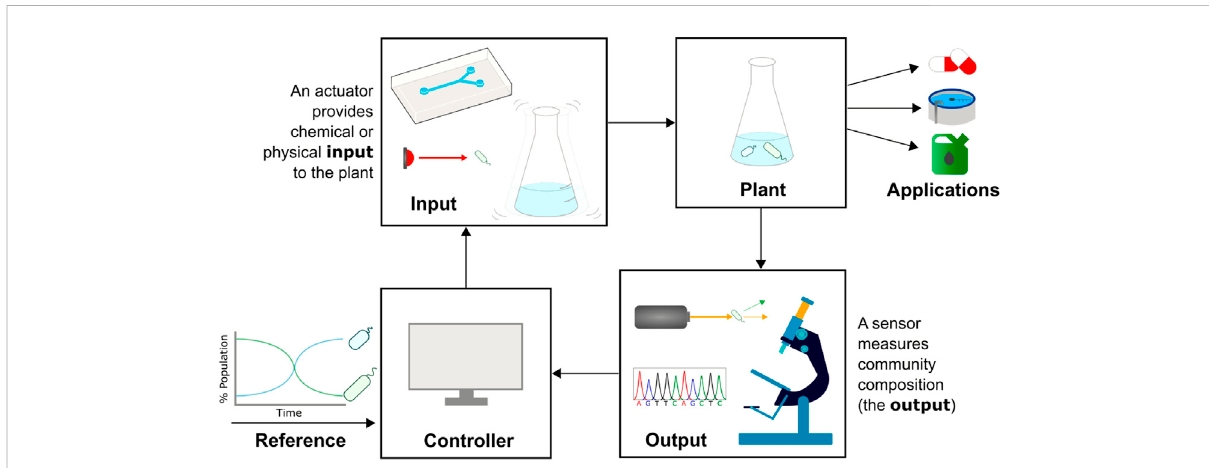
FIGURE 2 Cybergenetic control of community composition. The composition of a microbial community (plant, top right) needs to be controlled for optimal function, e.g., bioproduction or bioremediation. A sensor such as a fl ow cytometer, sequencer, or microscope is used to measure community composition in real-time (output). The measured and desired population data is fed into a computer acting as the controller, which decidesonacontrolaction.Anactuatorprovidesachemical(e.g.,injectingmediawithchemicalinducersintoamicro fl uidicdevice)orphysical (e.g., shining light or shaking the culture vessel) input to the plant that leads to a change in community composition, and the cycle is